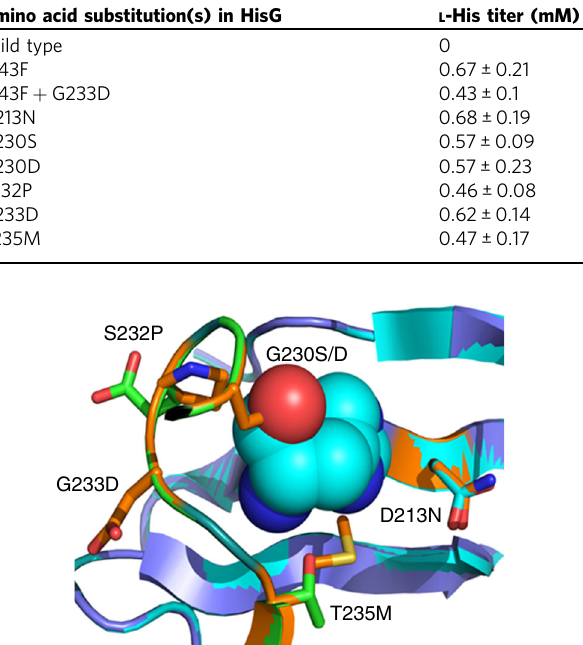
Supplementary Table 2. C. glutamicum was routinely cultivated aerobically at 30 °C in brain heart infusion (BHI) medium (Difco Laboratories, Detroit, USA) or de fi ned CGXII medium with 4% glucose, as sole carbon and energy source 33 . E. coli DH5 α used for plasmid constructions was cultivated in LB medium 34 at 37°C, E. coli BL21(DE3) used for heterologous gene expression was cultivated in 2× YT medium. Where appropriate, kanamycin (50µgmL − 1 for E. coli or 25 µgmL − 1 for C. glutamicum ) or spectinomycin (100µgmL − 1 for E. coli and C. glutamicum ) was added to the medium. Bacterial growth was followed by measuring the optical density at 600 nm (OD 600 ). Precultures of C. glutamicum were grown for 6 – 8 h in test tubes with 5mL BHI medium on a rotary shaker at 170 r.p.m. Subsequently, 50 mL de fi ned CGXII medium with 4% glucose in 500mL baf fl ed Erlenmeyer fl asks were inoculated with cells from the preculture and cultivated on a rotary shaker at 130 r.p.m.